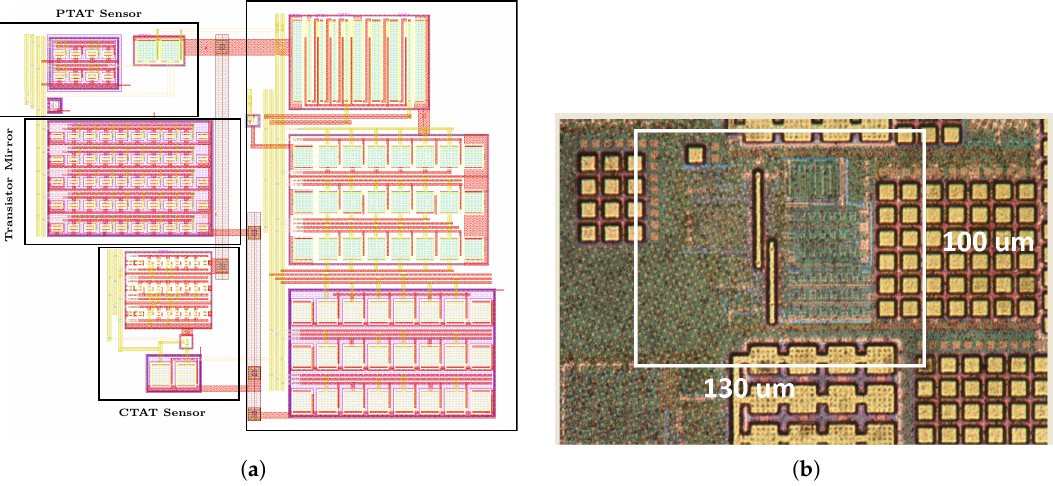
Figure 7. ( a ) Layout; and ( b ) Micrograph of the proposed temperature sensor